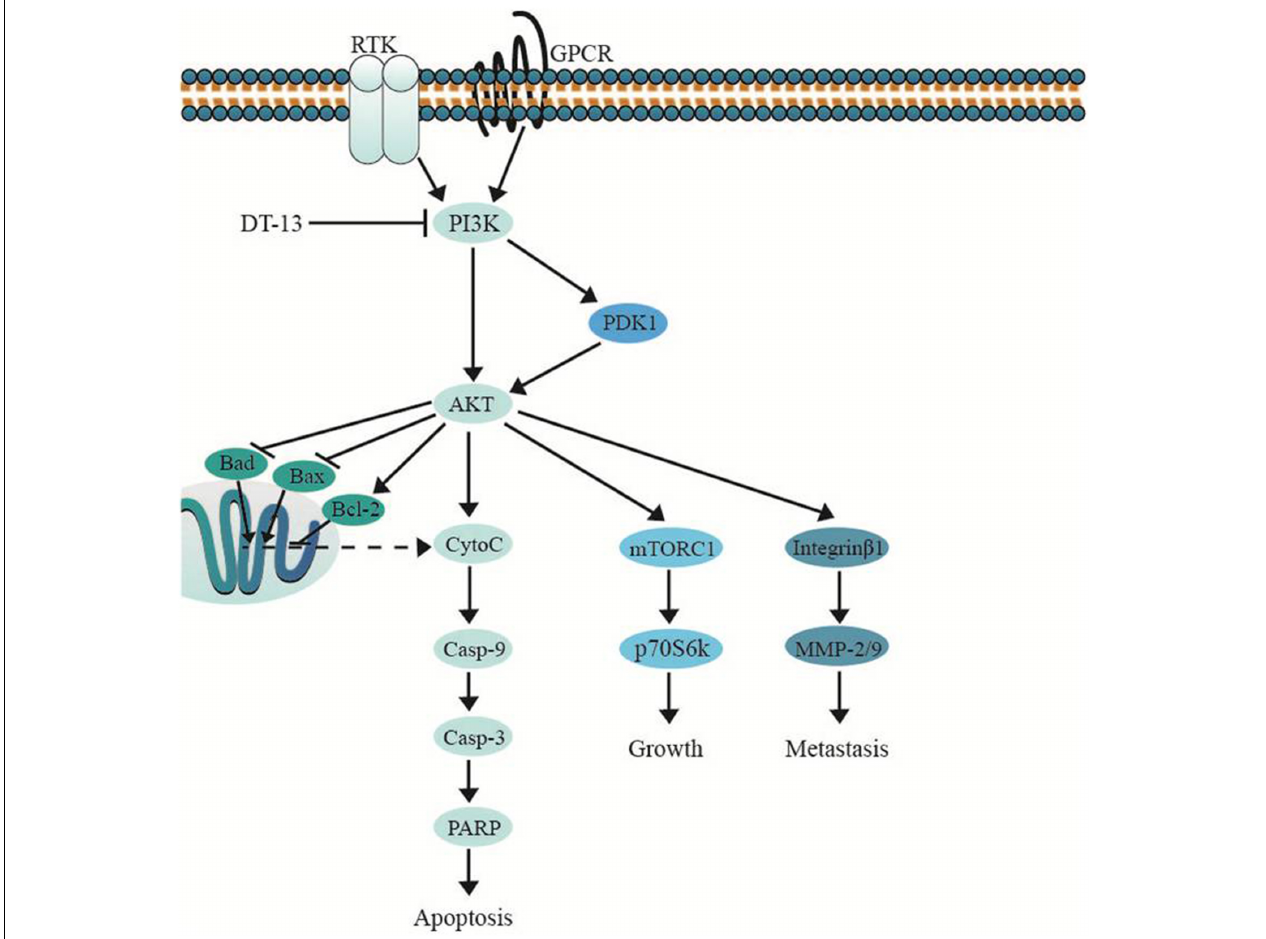
FIGURE 9 | DT-13 promoted mitochondrial apoptosis and inhibited metastasis via suppressing PI3K/Akt pathway.